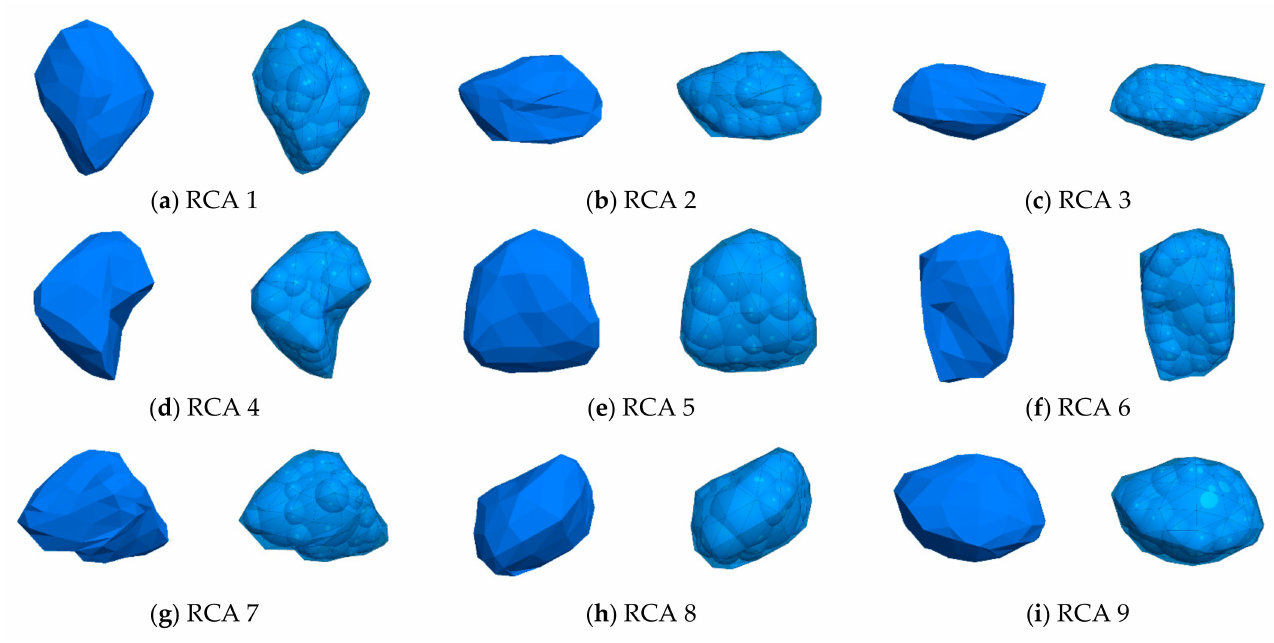
Figure 3. The flowchart of the new method of generating DEM particles with authentic shapes.